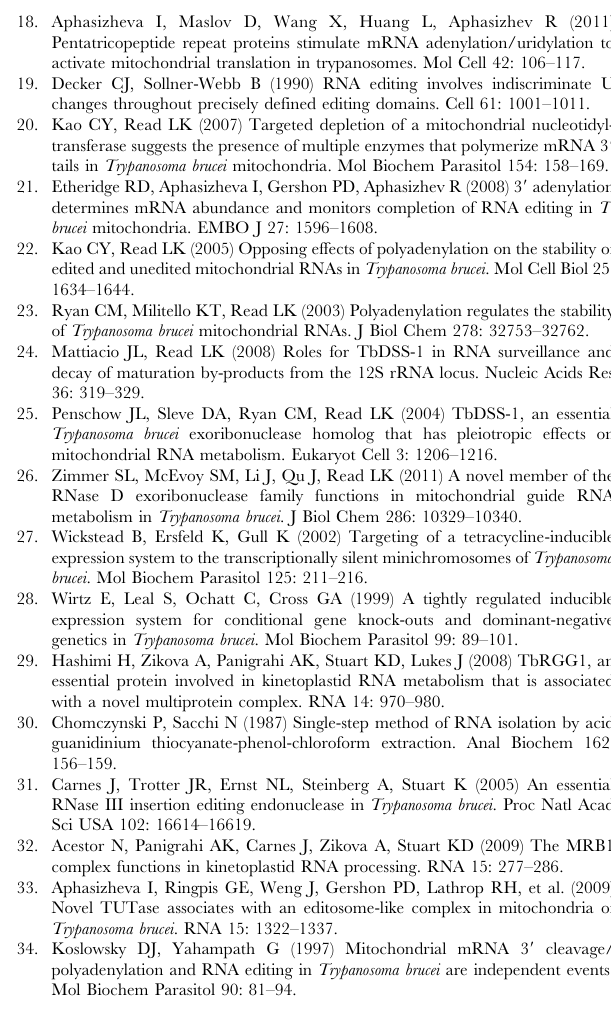
Figure S1 Circular RT-PCR primer locations. Relevant portions of sequences from ND4, RPS12, and MURF2 mRNAs are shown with primer locations indicated by arrows. Red arrows indicate reverse transcription primers, blue arrows indicate PCR primers, and the turquoise arrow indicates a nested PCR primer. (PDF) Dataset S1 Spreadsheet containing 3 9 non-encoded tails from the various cell lines used in this study. Tails acquired from the four transcripts examined are categorized in separate sheets of the Excel file, and categorized by different cell lines within each